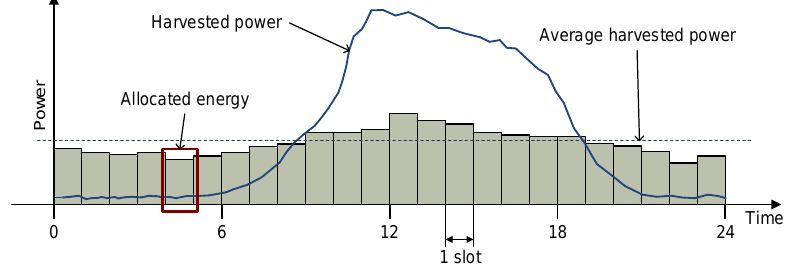
Figure 3. Energy allocation to the time slots.